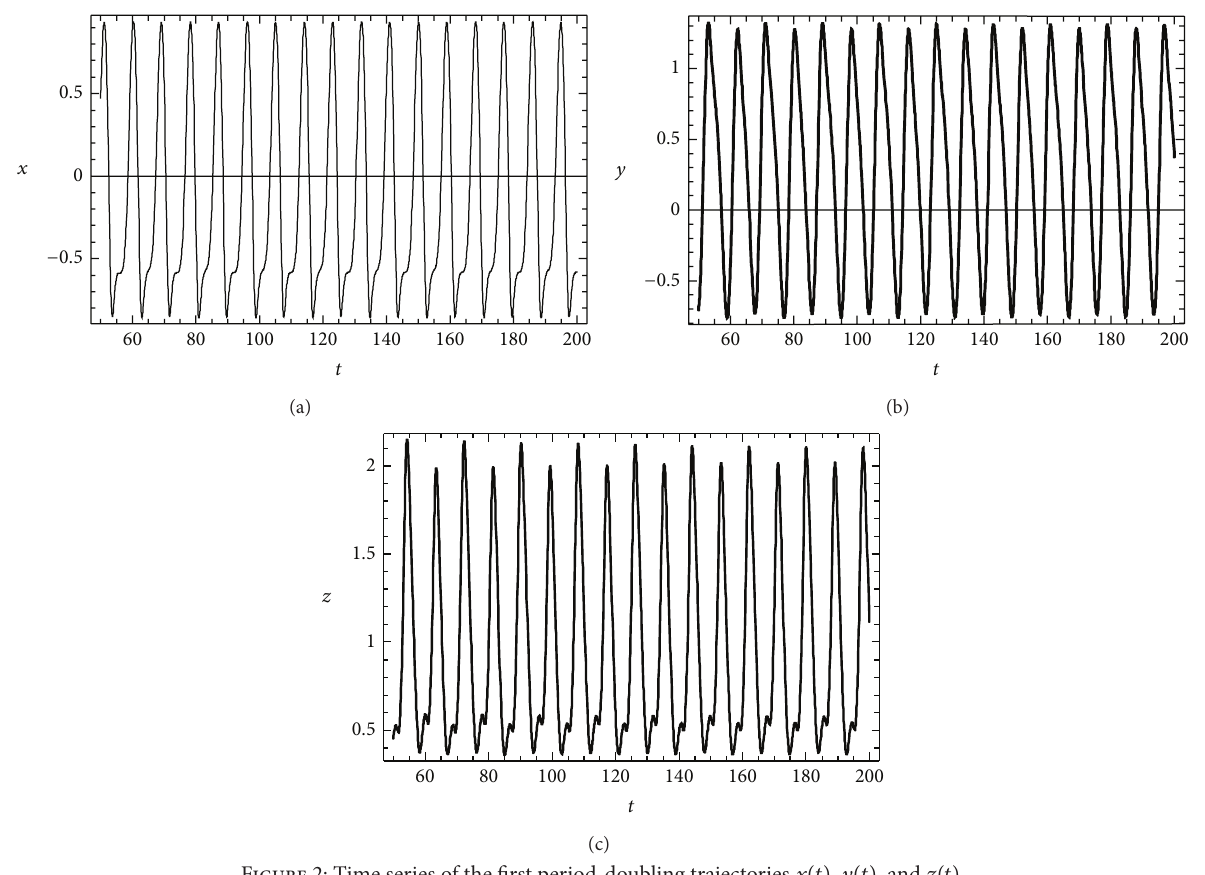
Figure 2: Time series of the first period-doubling trajectories 𝑥(𝑡) , 𝑦(𝑡) , and 𝑧(𝑡) .